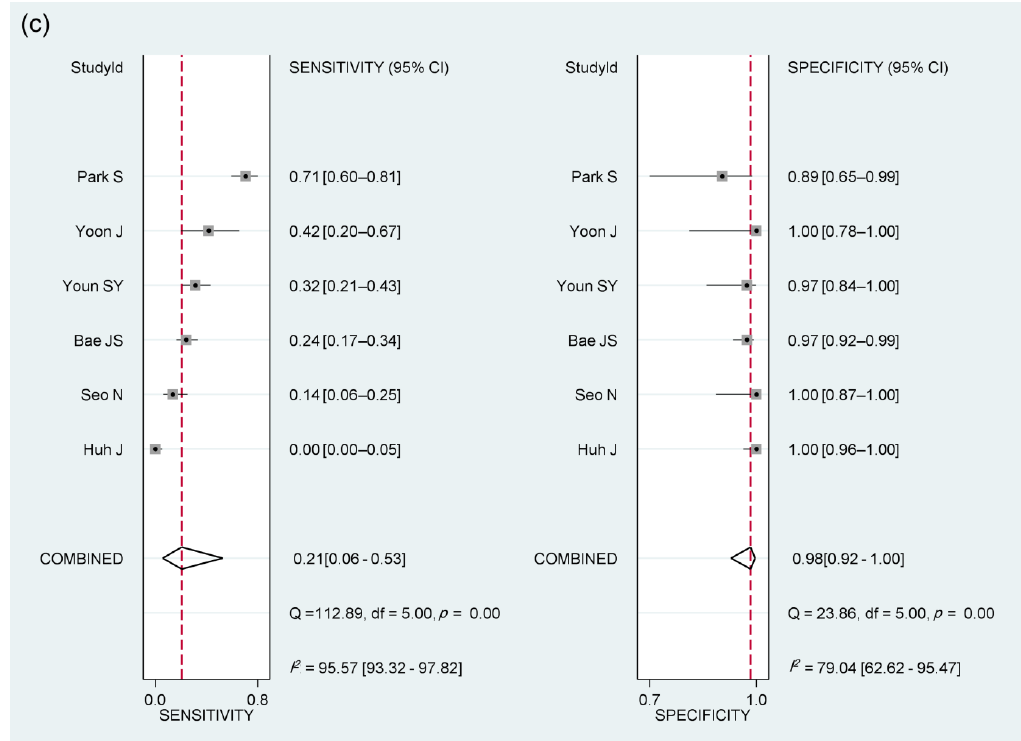
Figure 2. Coupled forest plots of sensitivity and specificity of arterial phase hyperenhancement ( a ), washout appearance ( b ), or enhancement similar to pretreatment ( c ) for diagnosing the viability of hepatocellular carcinoma.